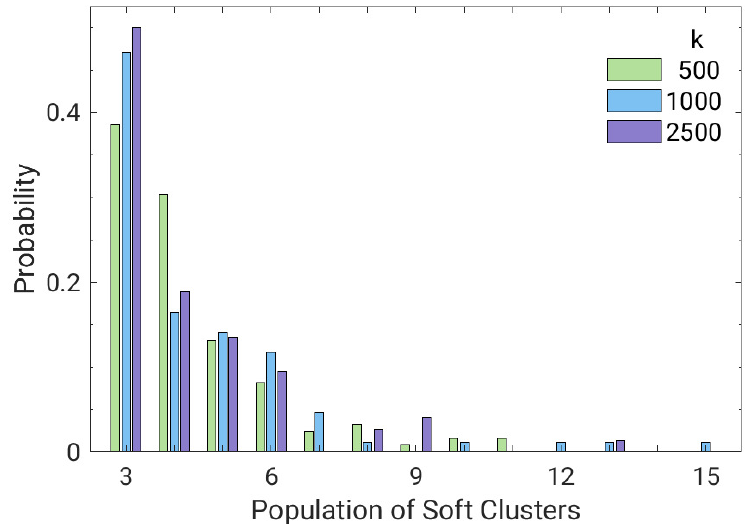
Figure 8. Distribution of the number of soft monomers belonging to a soft cluster.